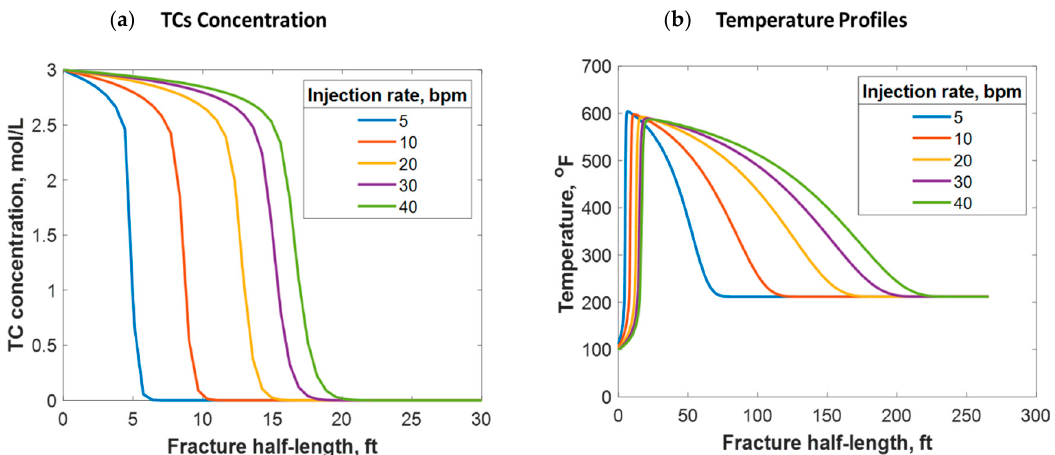
Figure 14. ( a ) TC concentrations and ( b ) fluid temperature profiles along the fracture half-length at different injection rates.